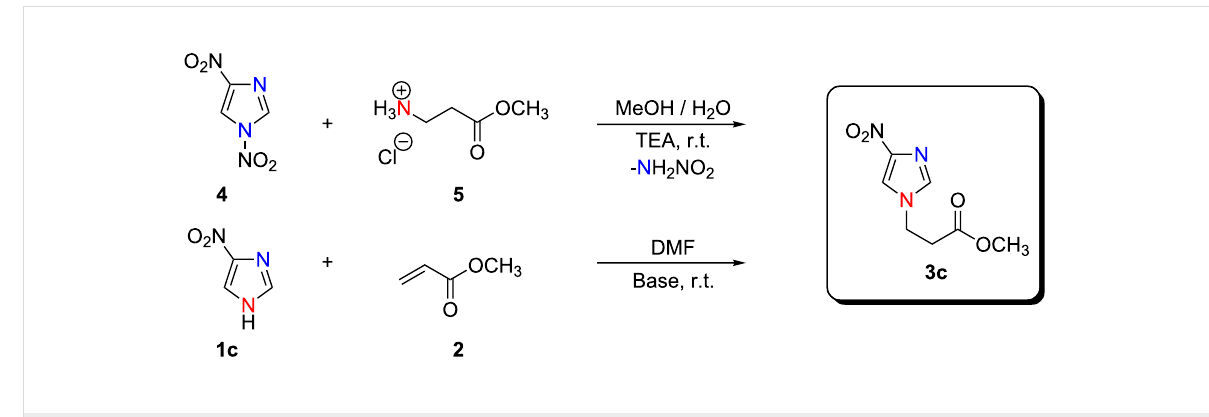
Scheme 2: Chemical evidence for a regioselective Michael-type addition of 4(5)-nitroimidazole ( 1c ) to methyl acrylate ( 2 ) based on the ANRORC reaction of 1,4-dinitroimidazole ( 4 ) with β -alanine methyl ester hydrochloride ( 5